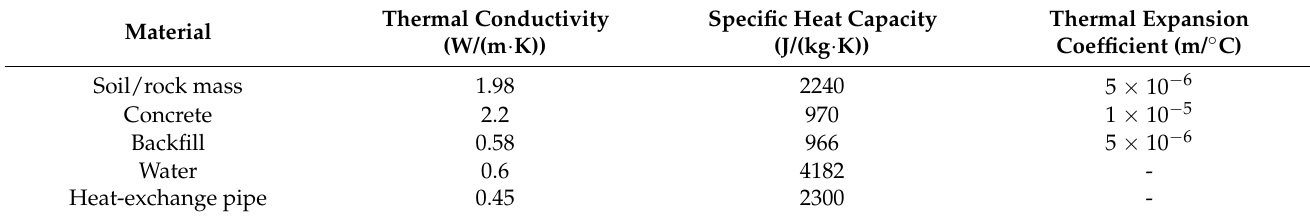
Table 2. Thermal and physical properties of each entity unit.